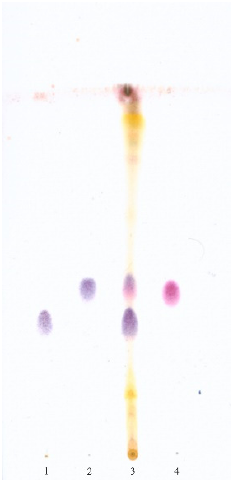
Figure 2. TLC of the purified AcOEt extract and phytoecdysteroids isolated from the S. coronata herb 1. 20-hydroxyecdysone; 2. polypodine B; 3. AcOEt extract of the S. coronata herb; 4. ajugasterone C; adsorbent: silica gel; mobile phase: CH 2 Cl 2 –MeOH 5:1.